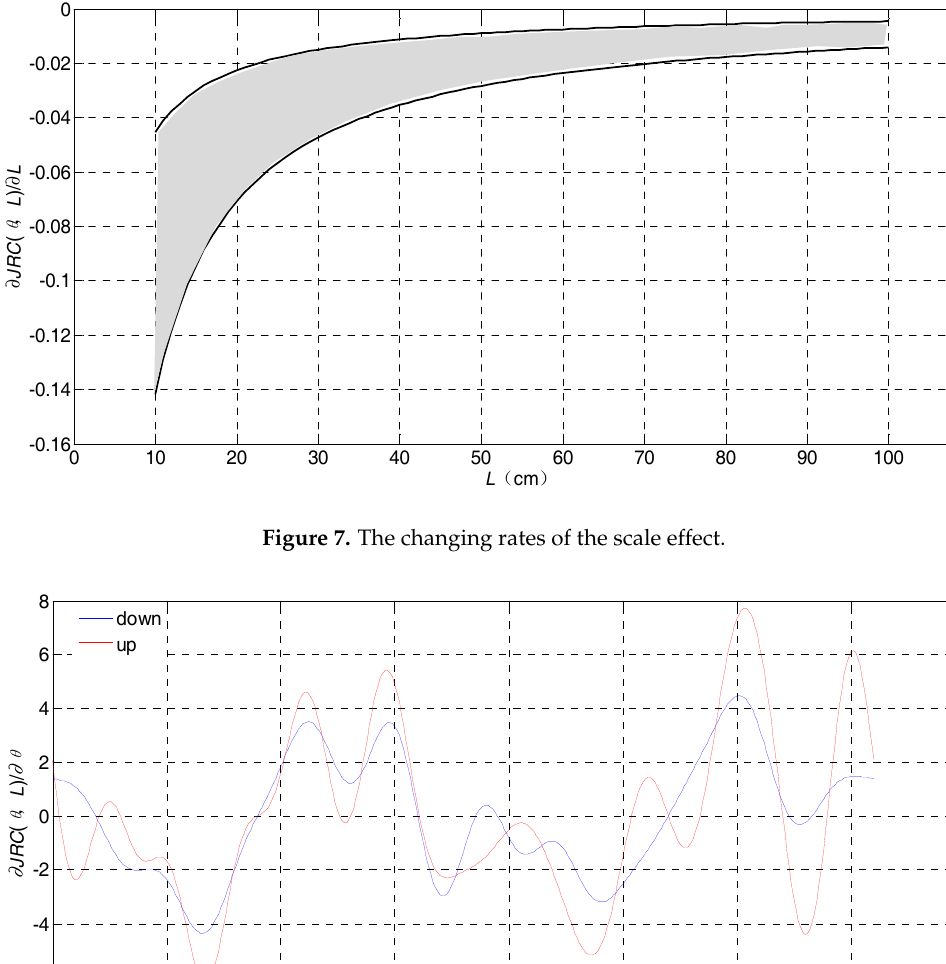
Figure 6. Curved surface area of JRC values corresponding to both L and θ .